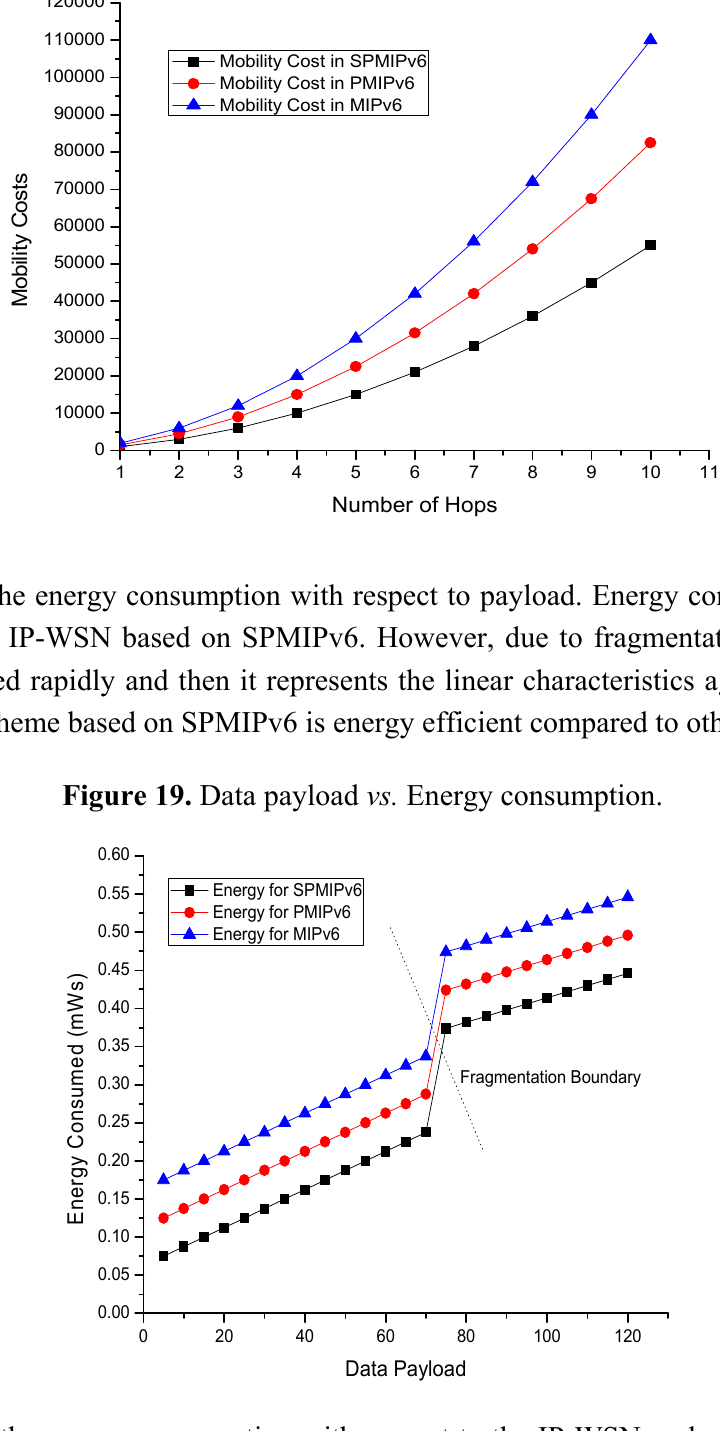
Figure 18. Number of Hops vs. Mobility Cost.